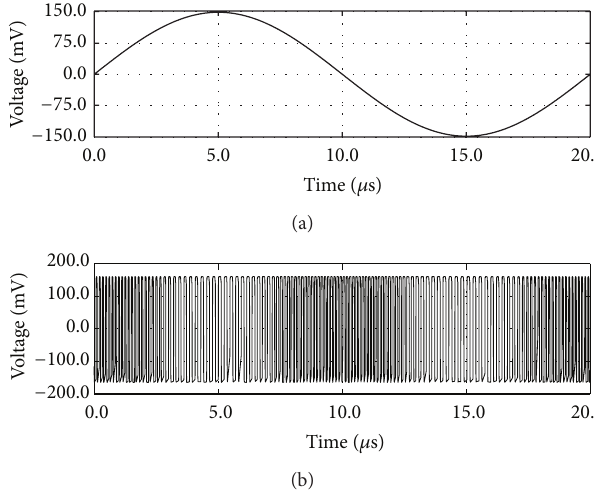
Figure 21: (a) Sinusoidal modulating signal and (b) delta modulated signal.